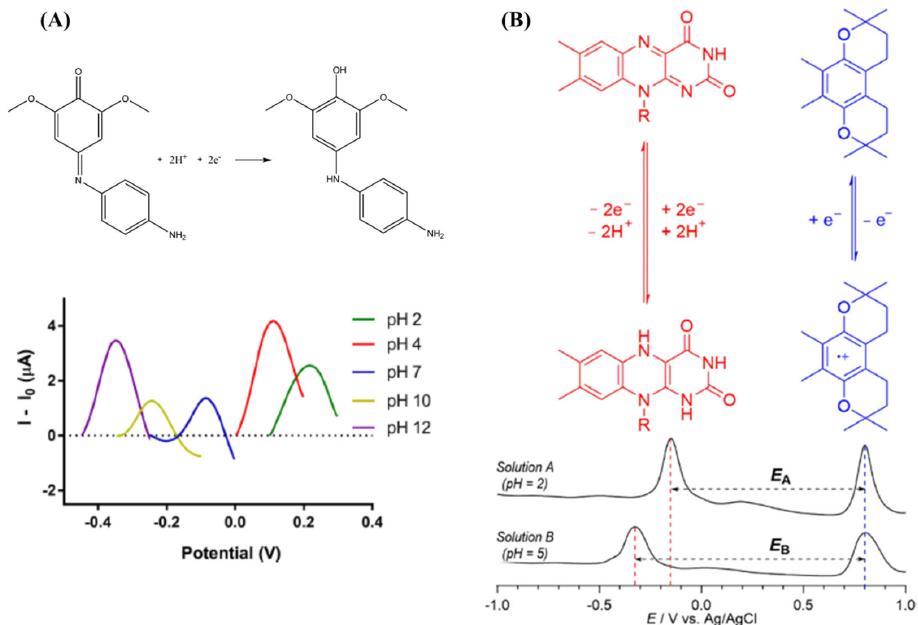
Figure 4. ( A ) Response of an indoaniline ‐ based voltammetric pH sensor (reprinted from [82] with the permission of Elsevier). ( B ) Square wave voltammetry of the vitamin ‐ based pH sensor (reprinted from [84] with the permission of